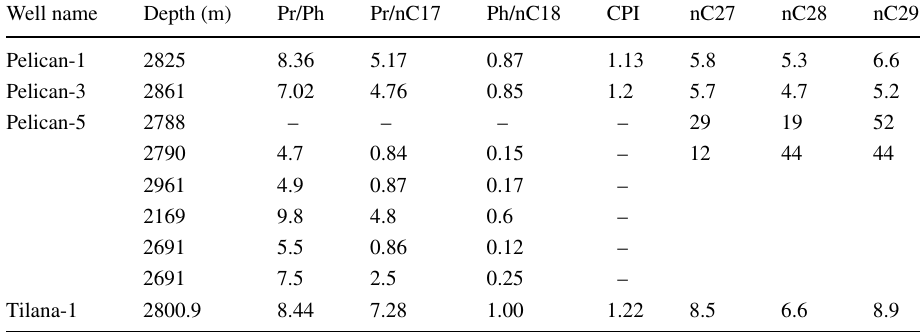
Table 4 Biomarker data and parameters calculated from n-alkanes and isoprenoids for Pelican-1, Pelican-3, Pelican-5 and